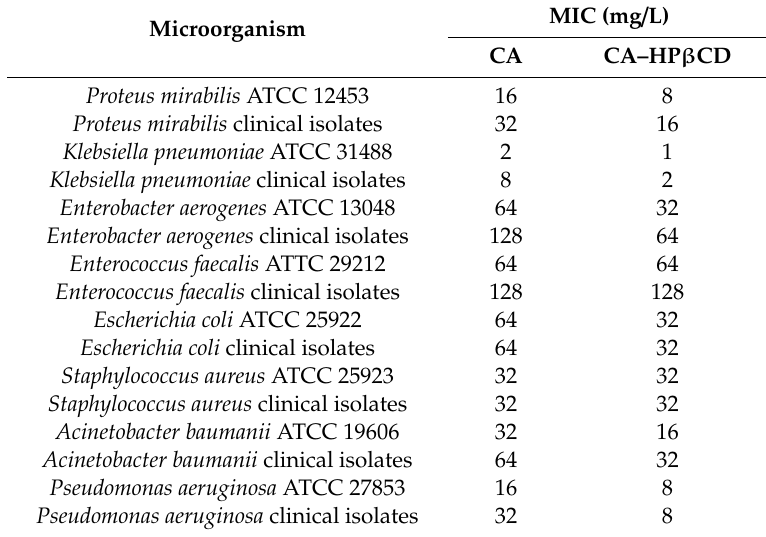
Figure 8. The apparent solubility profile of CA ( a ) and CA–HP β CD system ( b ). Table 2. The minimal inhibitory concentration (MIC) values measured for CA and CA–HP β CD complex on di ff erent species of Gram-negative